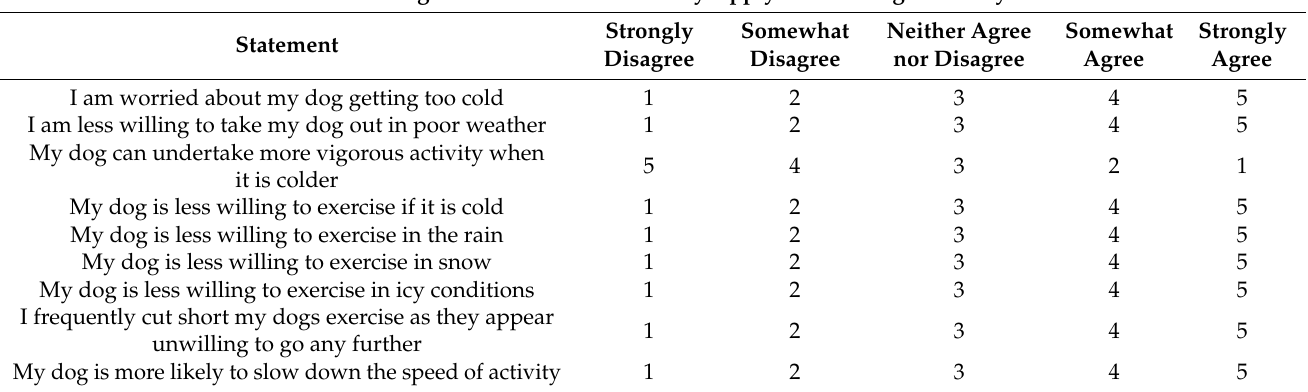
Table 1. Survey questions used to generate a winter canine activity score.